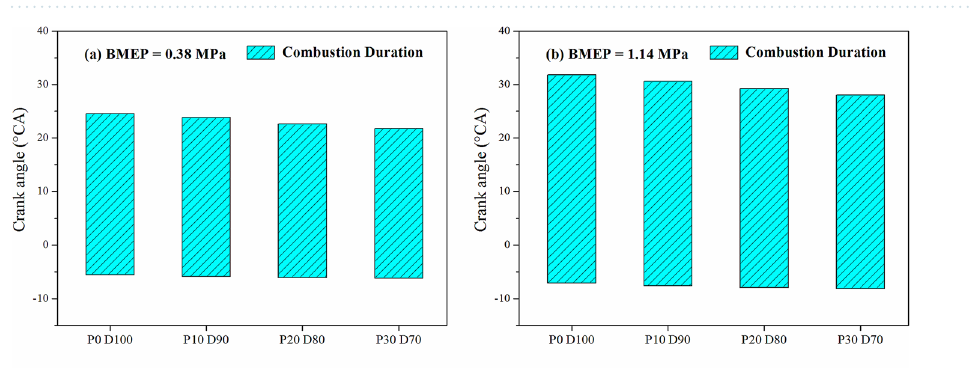
Figure 3. Effects of PODE n blending ratio on in-cylinder temperature.